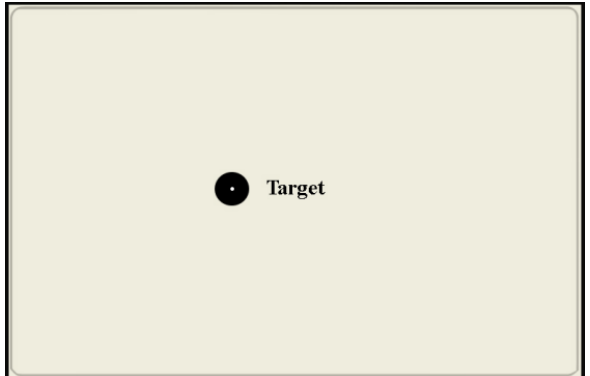
Figure 1: The experimental task.